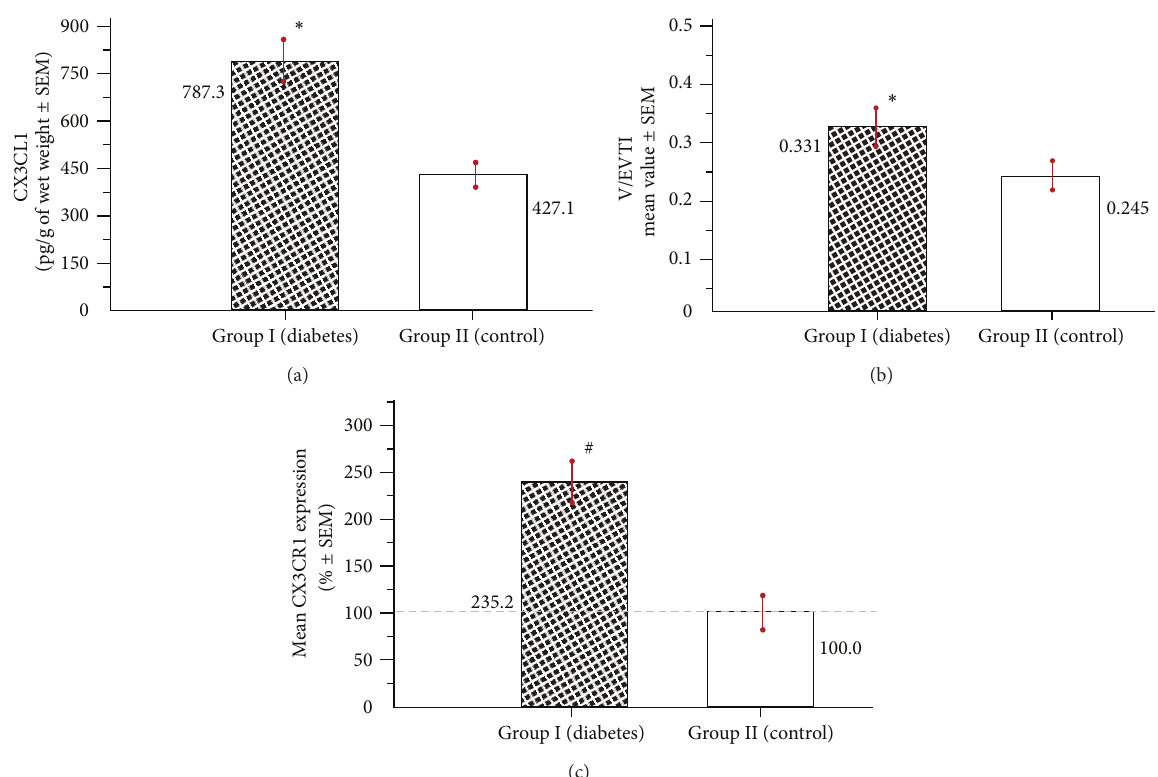
Figure 2: Placental samples collected after diabetes class C (group I) versus specimens obtained after normal pregnancy (group II): (a) the mean concentration of CX3CL1; (b) density of the microvessels estimated using the mean vascular/extravascular tissular index (V/EVTI); (c) the mean percentage expression of CX3CR1. The values obtained for normal pregnancy ( 0.016±0.0014 ; abstract numbers ± SEM) were taken as 100% ( ∗ 𝑃 < 0.05 ; # 𝑃 < 0.01